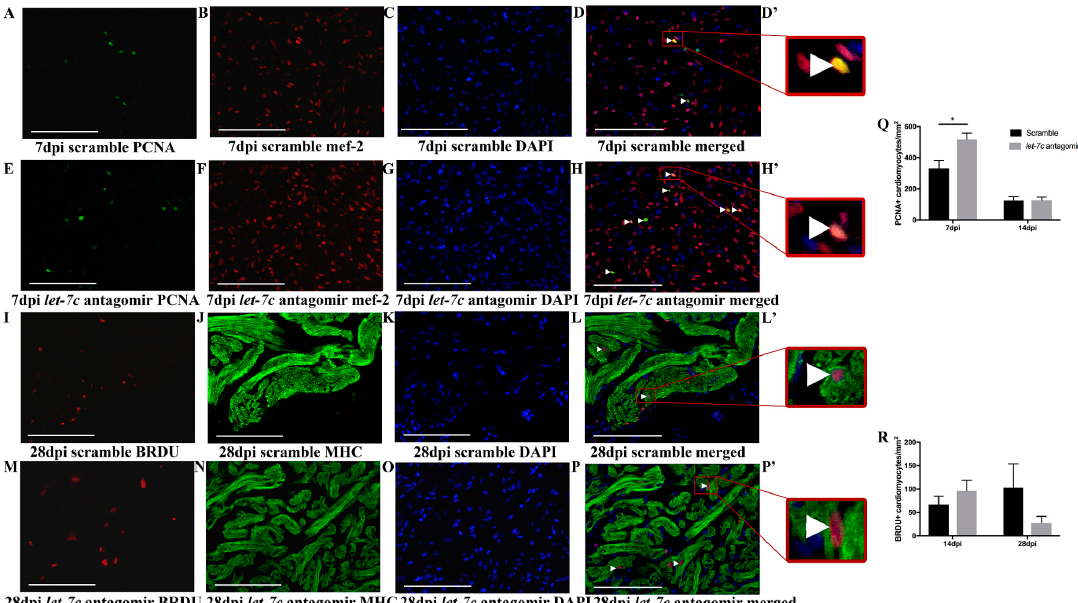
Figure 4. Quantification of proliferating cardiomyocytes in cryoinjured hearts . Representative images at 7 dpi of PCNA, mef-2, DAPI, merged image and inset of merged image in scramble ( A – D , D’ ) and in let-7c antagomir hearts ( E – H , H’ ). Representative images at 28 dpi of BRDU, MHC, DAPI, merged image and inset of merged image in scramble ( I – L , L’ ) and in let-7c antagomir hearts ( M – P , P’ ). Positive cardiomyocytes marked with arrowheads. In PCNA images (A–H’) mef-2 marks cardiomyocytes in red, PCNA positive cells marked in green and DAPI nuclei marked in blue. In BRDU images ( I – P’ ), MHC marks myocardium in green, BRDU positive cells marked in red and DAPI nuclei marked in blue. Insets are magnified images of merged image ( D’ , H’ , L’ , P’ ). Newly formed cardiomyocytes are quantified by PCNA staining at 7 dpi and 14 dpi ( Q ) and by BRDU labeling at 14 dpi and 28 dpi ( R ). (PCNA: n = 3 for 7 dpi antagomir and scramble, n = 8 for 14 dpi antagomir and scramble. BRDU: n = 10 for 14 dpi antagomir, n = 9 for 14 dpi scramble, n = 8 for 28 dpi antagomir and n = 6 for 28 dpi scramble). Scale bar: 100 µ m. * p ≤ 0.05.